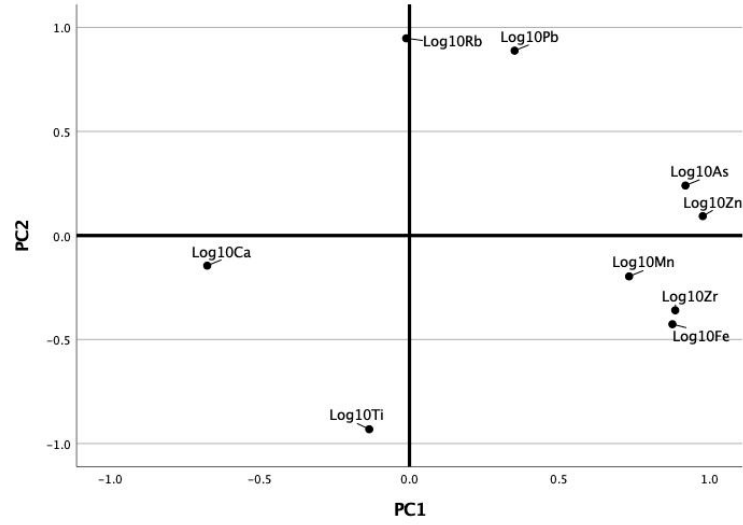
Figure 7. Bivariate plot of loading PC1 and PC2.